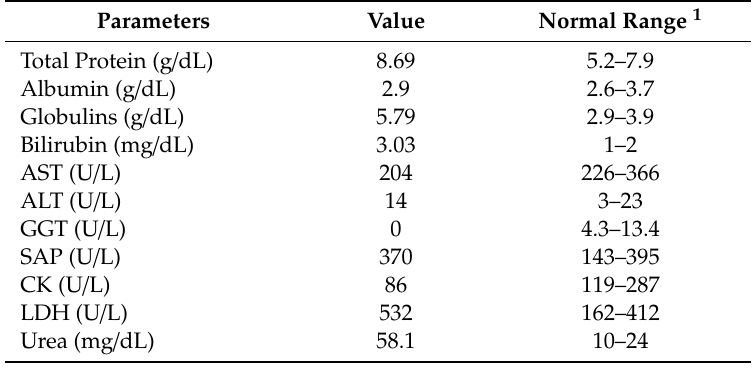
Table 2. Biochemical profile from a horse a ff ected by dermal geotrichosis for two months, with severe dermatitis, exhibiting fever, inappetence, elevated heart and respiratory rate the time of blood